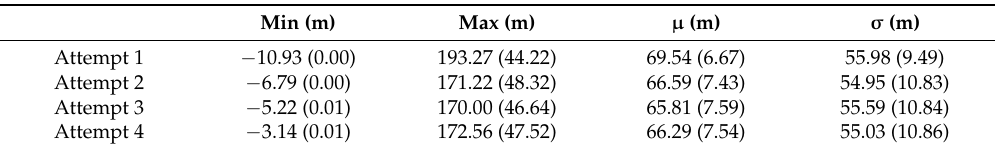
Table 7. Results of the flight path deviation for real flight experiments with a UAV speed of 15 m/s and a 2–3 m/s southwest